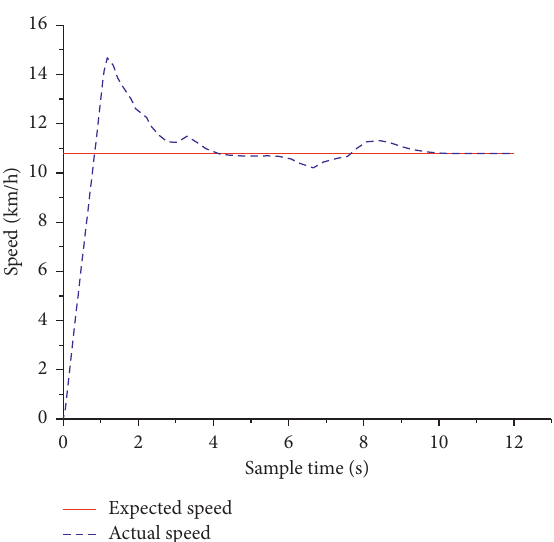
Figure 17: Simulation diagram of steering wheel angle. Figure